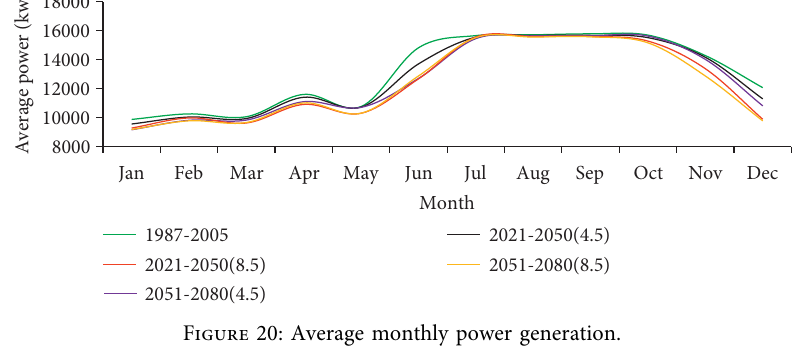
Figure 20: Average monthly power